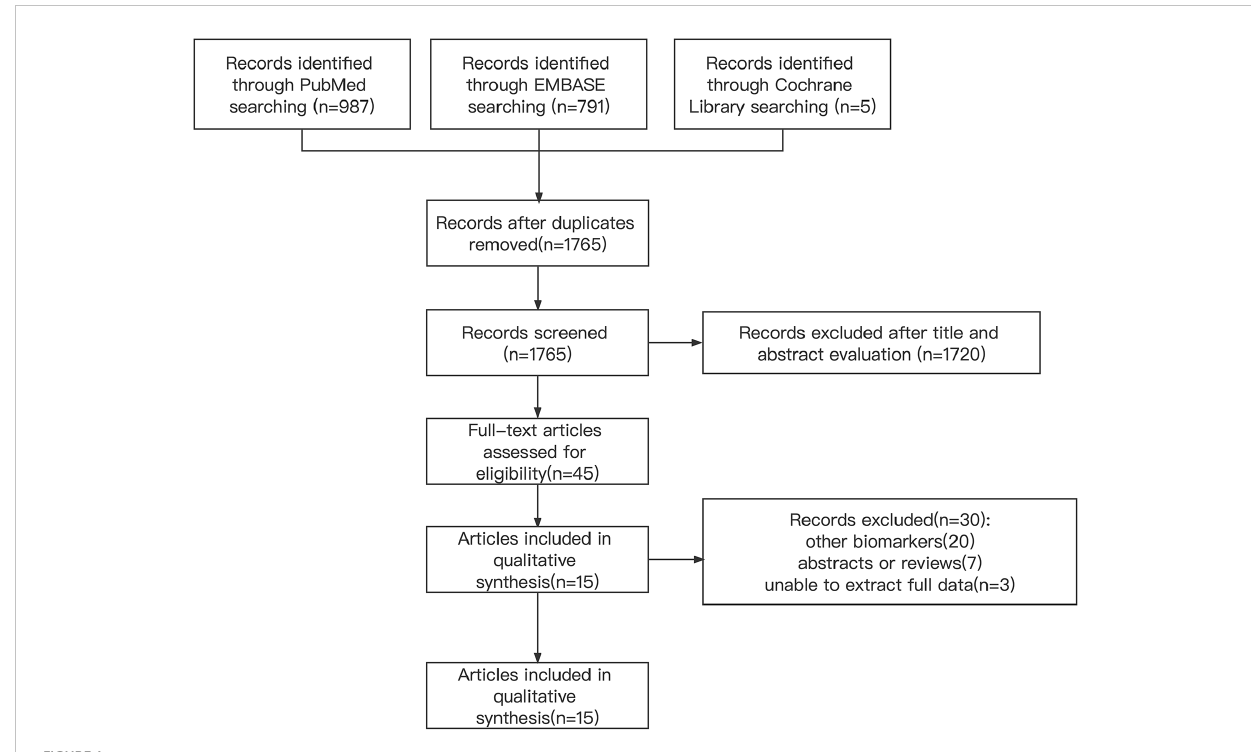
FIGURE 1 Flowchart of literature